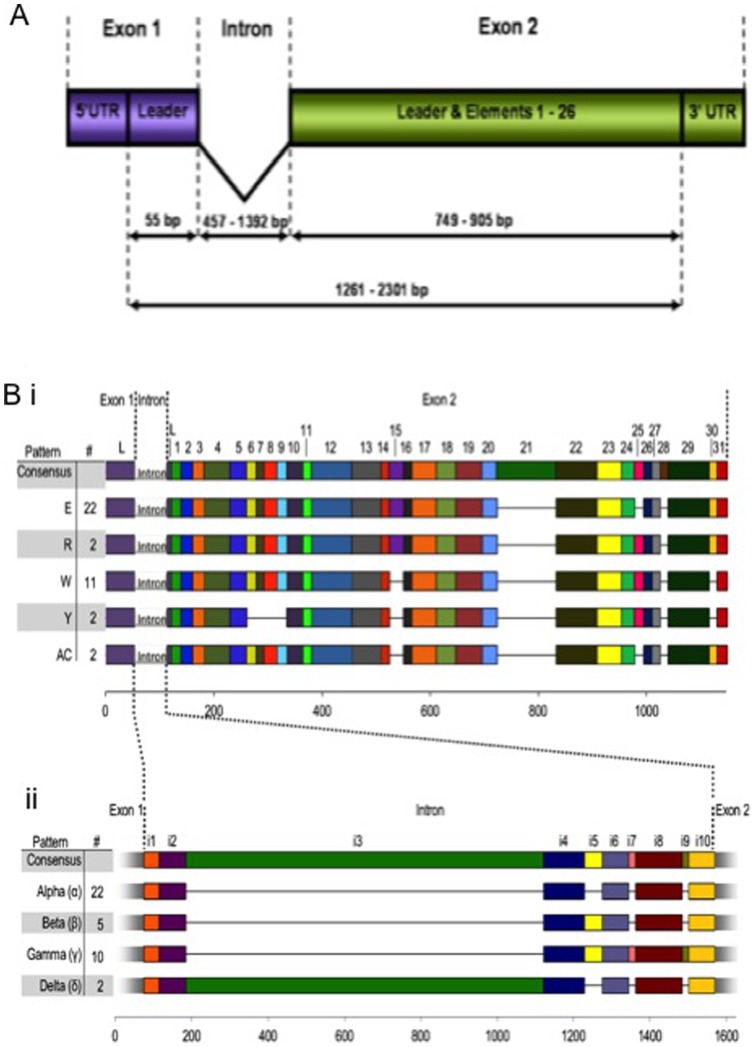

He185/333 gene structure.
A. Genes consist of a short exon 1 and a longer exon 2, separated by one intron. The leader is 63 bp in length and is interspersed between positions 55/56 by the Intron. Thus, the leader represents exon 1 (excluding the 5′UTR) but also forms the first eight nucleotides of the second exon. The intron varies in size between 457 bp and 1392 bp. The second, long exon ranges from 749 bp to 905 bp (excluding the 3′UTR) and contains the mosaic organisation of elements. The 5′ and 3′ UTRs of He185/333 genes have only been partially sequenced. B. Element patterns of 39 manually aligned
He185/333
 gDNA sequences. i. The coding regions (exons 1 and 2) are interspersed by one intron, dividing the leader in two parts, as indicated at the top of the diagram. Genes identified to-date show the five exon element patterns E, I, R, W and Y as described for cDNAs in figure 1A. Introns are simplified by interrupted, checkered boxes. The consensus at the top of the diagram is based on all element patterns, including cDNA element patterns as shown in figure 1A. ii. Similar to exons, introns align optimally with insertion of large gaps, resulting in ten intron elements and four intron element patterns, designated alpha (α), beta (β), gamma (γ) and delta (δ). Individual intron elements are named i1 to i10 and are shown as differently shaded gray boxes. Exons are represented as fading extensions to the left and right of intron element patterns. i & ii. Combinations of exon and intron element patterns define gene element patterns of which the following nine have been identified among the 39 gene sequences (number of individual sequences with according gene element pattern in brackets: E-α (11), I-α (2), W-α (8), Y-a (1), E-β (2), R-β (2), W-β (1), E-γ (10), W-δ (2). The first element pattern is the consensus.